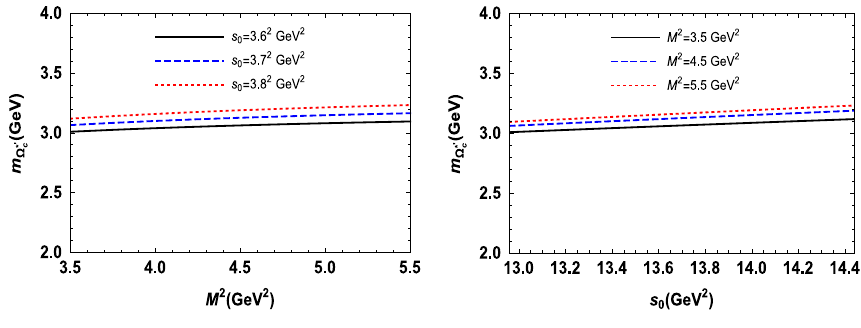
Fig. 4 The same as in Fig. 1, but for the radially excited (cid:2) (cid:4) (cid:4) c baryon